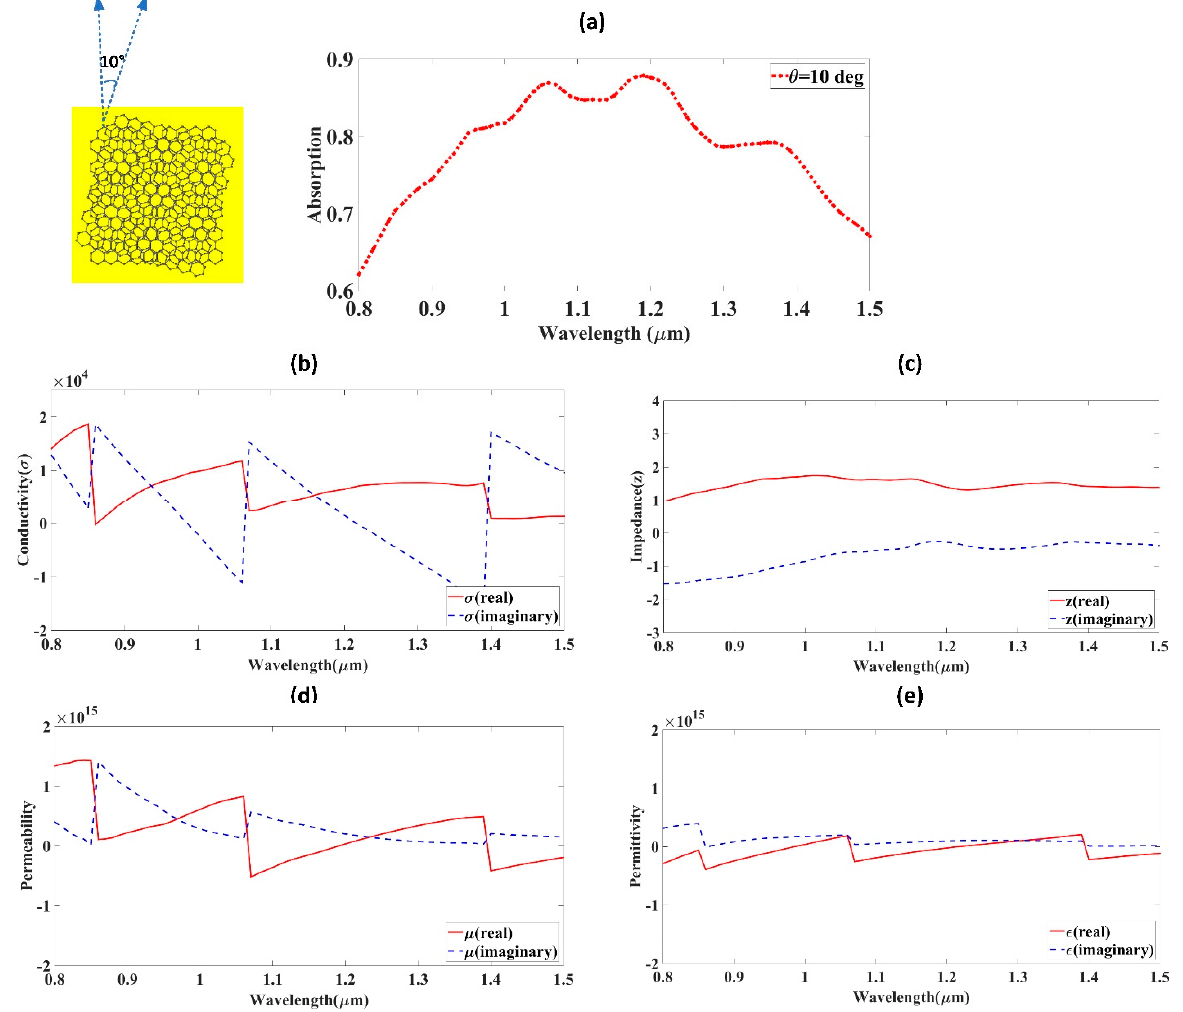
Figure 4. Bilayer graphene with twist angle of 10°. ( a ) Absorption; ( b ) conductivity (Re and Imag); ( c ) impedance (Re and Imag); ( d ) permeability (Re and Imag); ( e ) permittivity (Re and Imag). The inset fi gure shows the schematic of bilayer graphene with a twist of 10°.